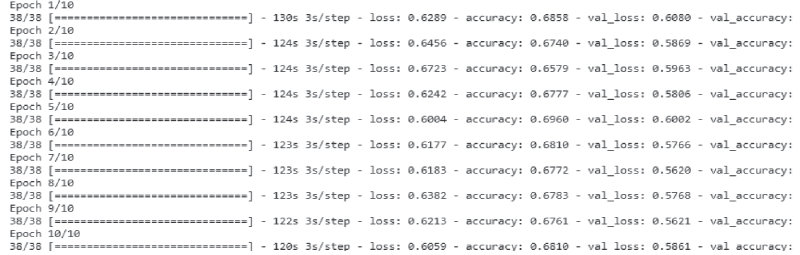
Figure 8: Overall accuracy of EfficientNetB0 model.